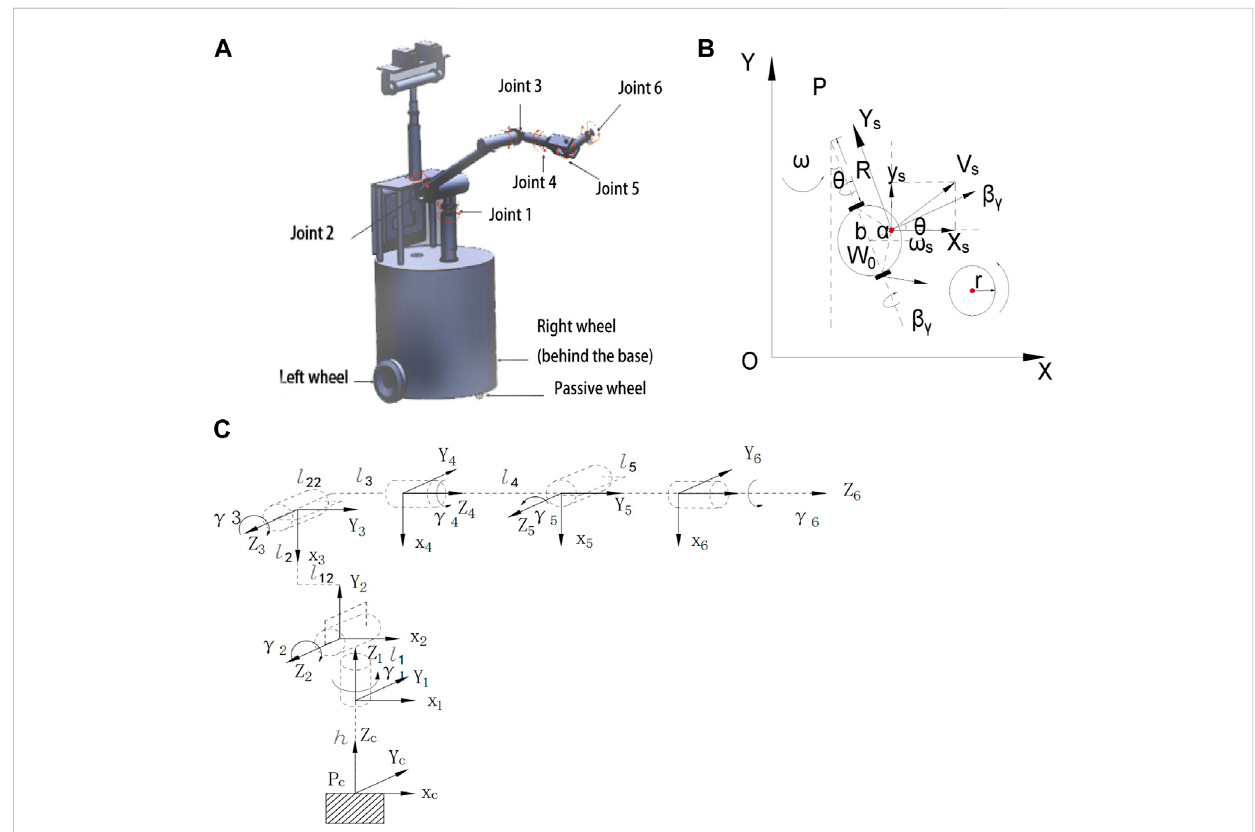
FIGURE 5 Wheeled robot modeling process. (A) is 3D model, (B) is the model of mobile platform, (C) is Wheeled robot world coordinate system and axis coordinate